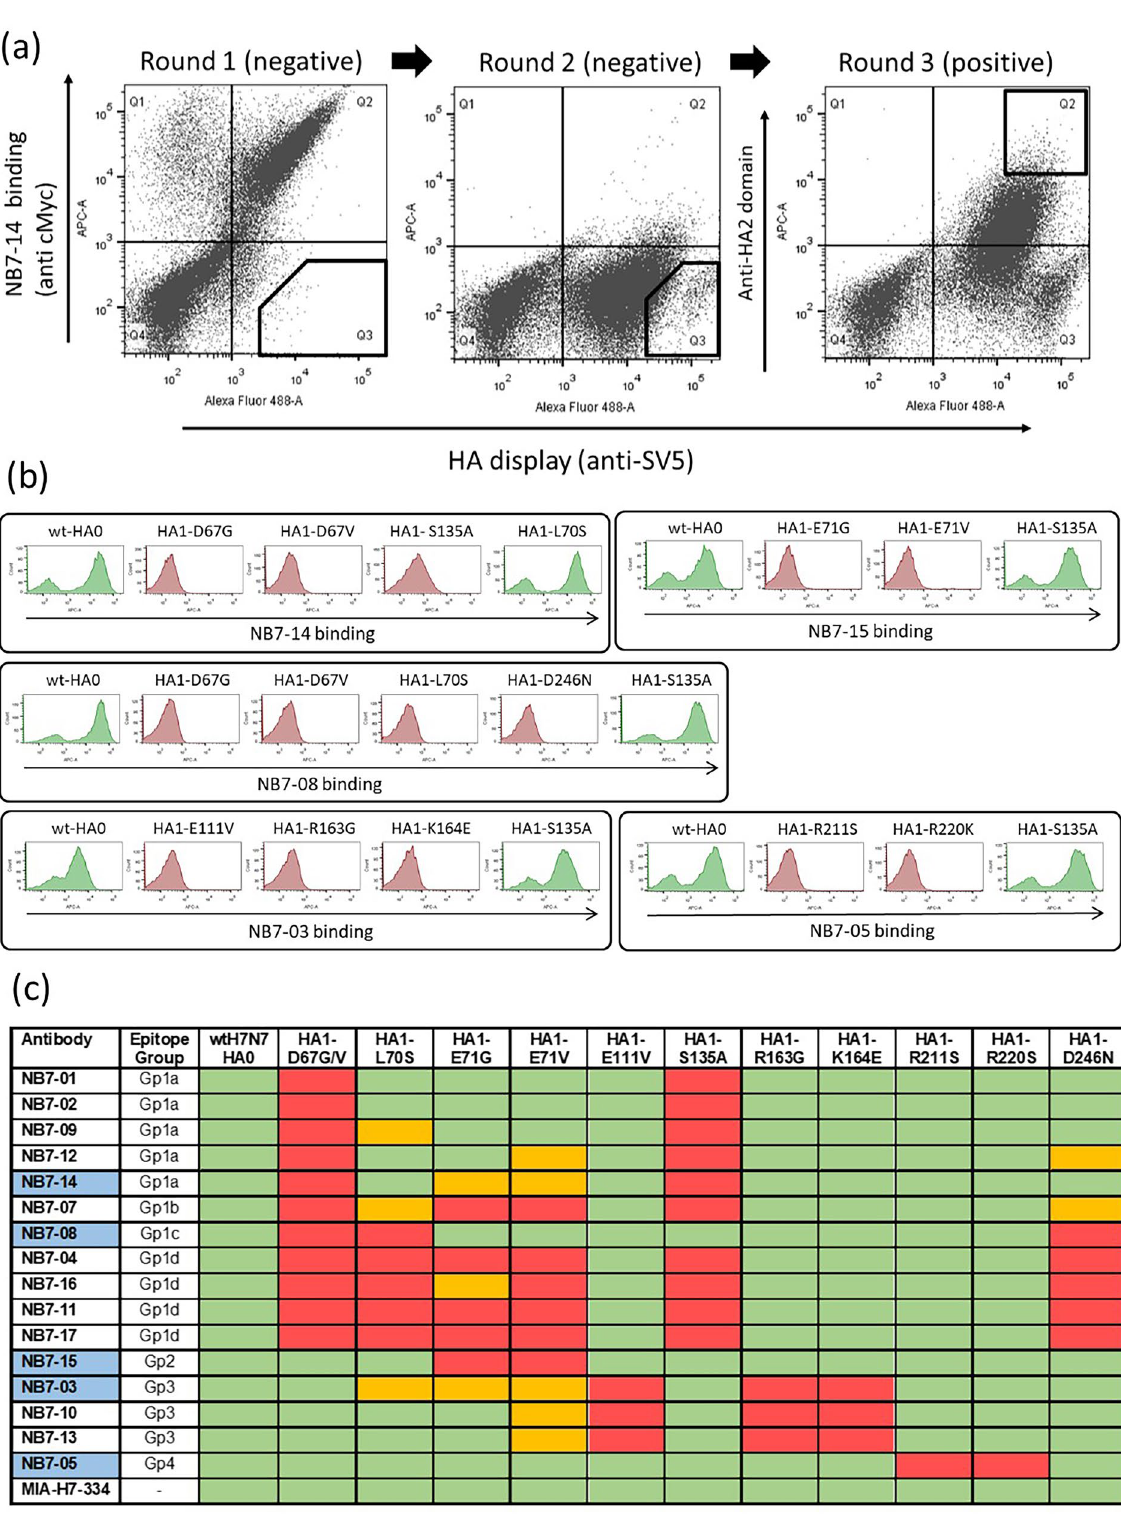
Figure 3. Epitope footprints of H7-HA specific nanobodies. ( a ) Example selection campaign for NB7-14 showing two rounds of ‘negative’ selection followed by a third round of ‘positive’ selection. ( b ) Flow cytometry histograms (FlowJo 10.4 software) showing Nb binding to yeast displayed wild-type H7-HA0 (A/Netherlands/219/2003) and binding of NB7-14, NB7-08, NB7-15, NB7-03, NB7-05 to yeast displayed HA carrying the mutations as indicated. ( c ) Binding activity to a panel of yeast displayed H7-HA0 mutants with residue numbering relative to HA1 domain. Each Nb is grouped by binding profile. Blue cells indicate the specific Nb used for HA library selections. Commercial H7-HA specific antibody MIA-H7-334 is included as positive control and retains binding to all mutants. Relative Nb binding to each yeast displayed HA mutant was calculated by dividing the MFI (mean fluorescence intensity) of Nb-mutant HA pair with the value for wild type H7-HA incubation and the resulting ratio normalised to percentage values. Binding was categorized as follows, ≤ 15% no binding (red), between 15 and 40% intermediate binding (orange) and ≥ 40% positive binding